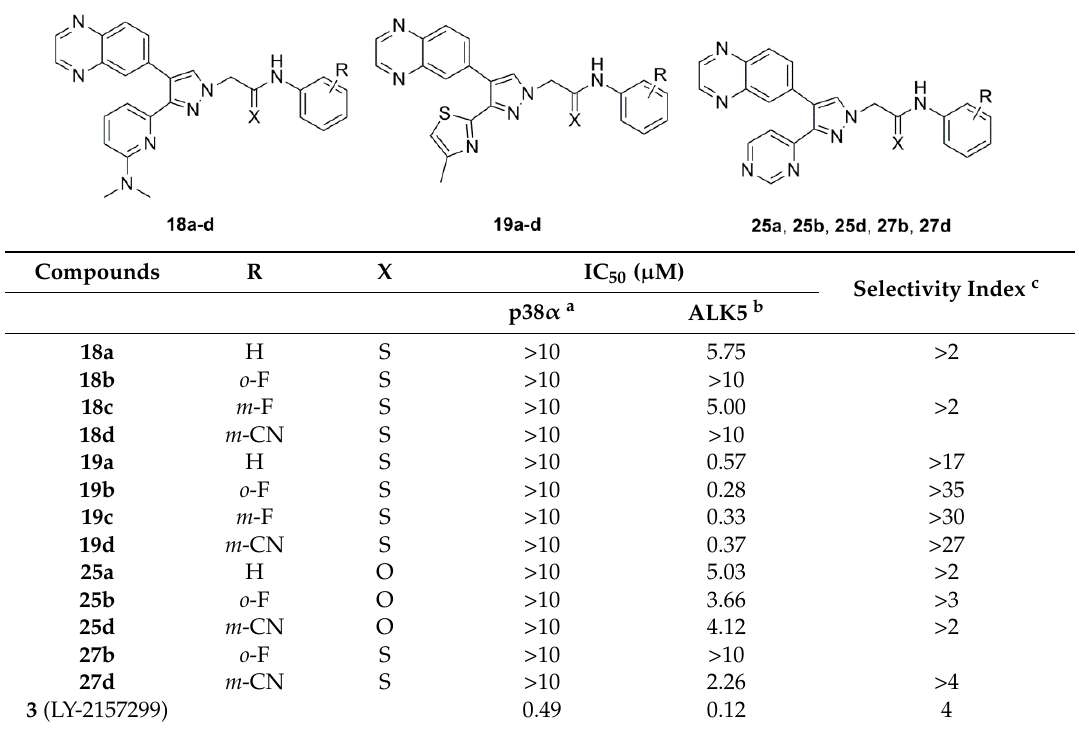
Table 2. Inhibitory activity of 3-substituted-4-(quinoxalin-6-yl) pyrazoles 18a – d , 19a – d , 25a , 25b , 25d , 27b , and 27d against ALK5 and p38 α MAP kinase.